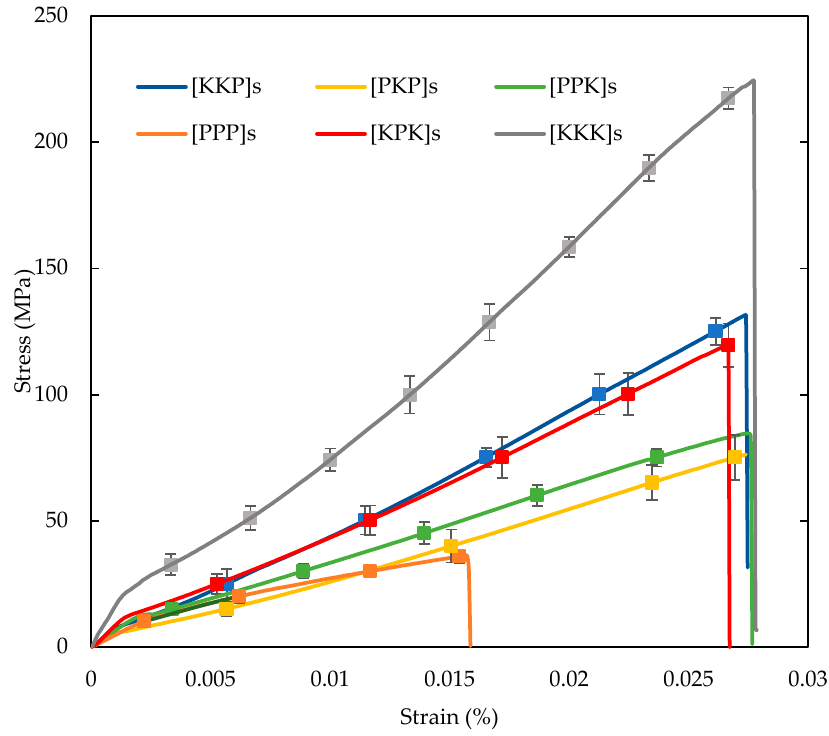
Figure 6. Tensile stress–strain curve of PALF/Kevlar ‐ reinforced UP hybrid composite laminates with various stacking sequences.